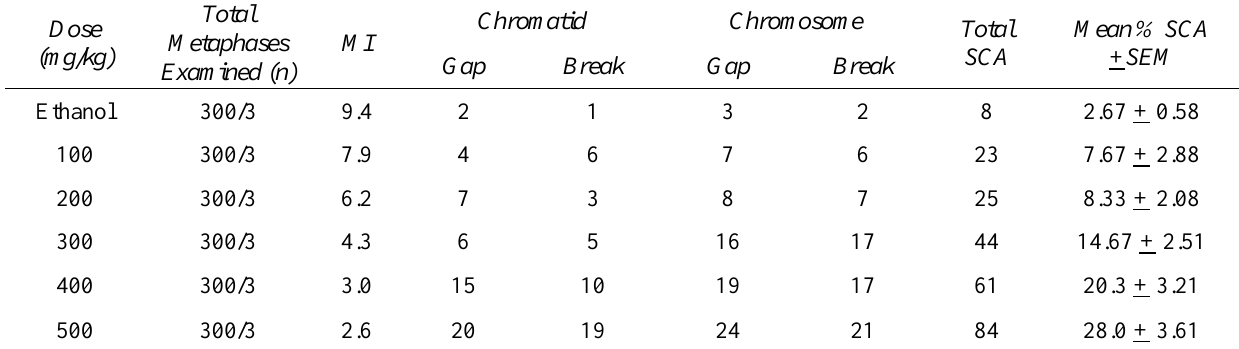
Table 1: Frequency of chromosome aberrations in bone marrow cells of Swiss-Webster mice induced by 1,1- Dichloroethane.